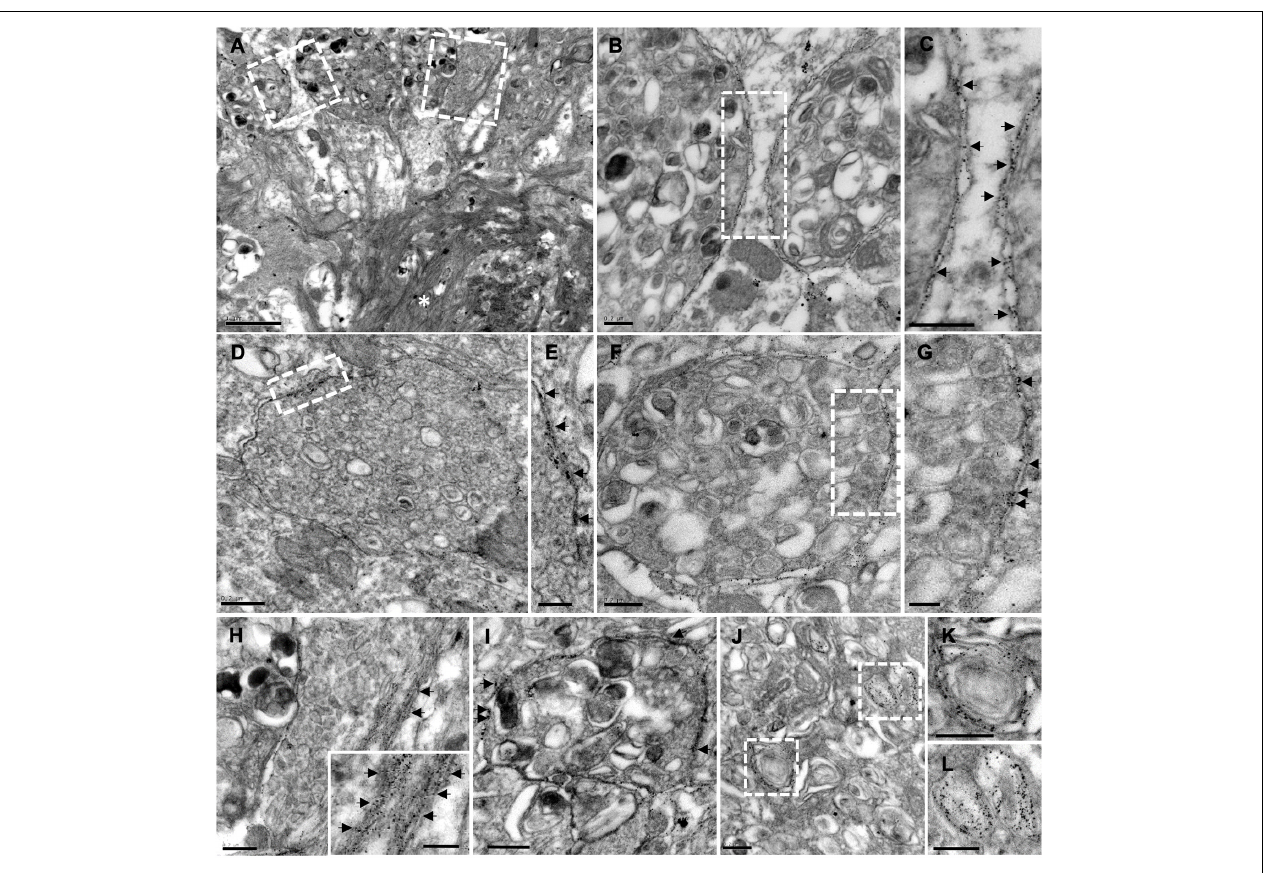
FIGURE 7 | Plaque-associated dystrophic neurites as a source of A β 42. TEM images from A β 42-immunogold labeled hippocampus from 6-month-old APP/PS1 mice. (A) A β 42-labeling evidenced the presence of this amyloid isoform, not only within the plaque (asterisk), but also in the membrane of periplaque dystrophic neurites (B–H) . Arrows in the corresponding details (C,E,G) and (H,I) point to the gold particles. Inset in panel (H) depicts amyloid fibers intermingled with a dystrophic process. (I,J) A β 42-positive swollen axonal/presynaptic neuronal processes were filled with vesicular compartments related to autophagy-lysosomal pathway [details at higher magnification in panels (K,L) ], which were positive to A β 42. Scale bars, (A) 1 µ m; (B–D,F,H–L) 0.2 µ m; (E–G) , inset in panel (H) 0.1 µ